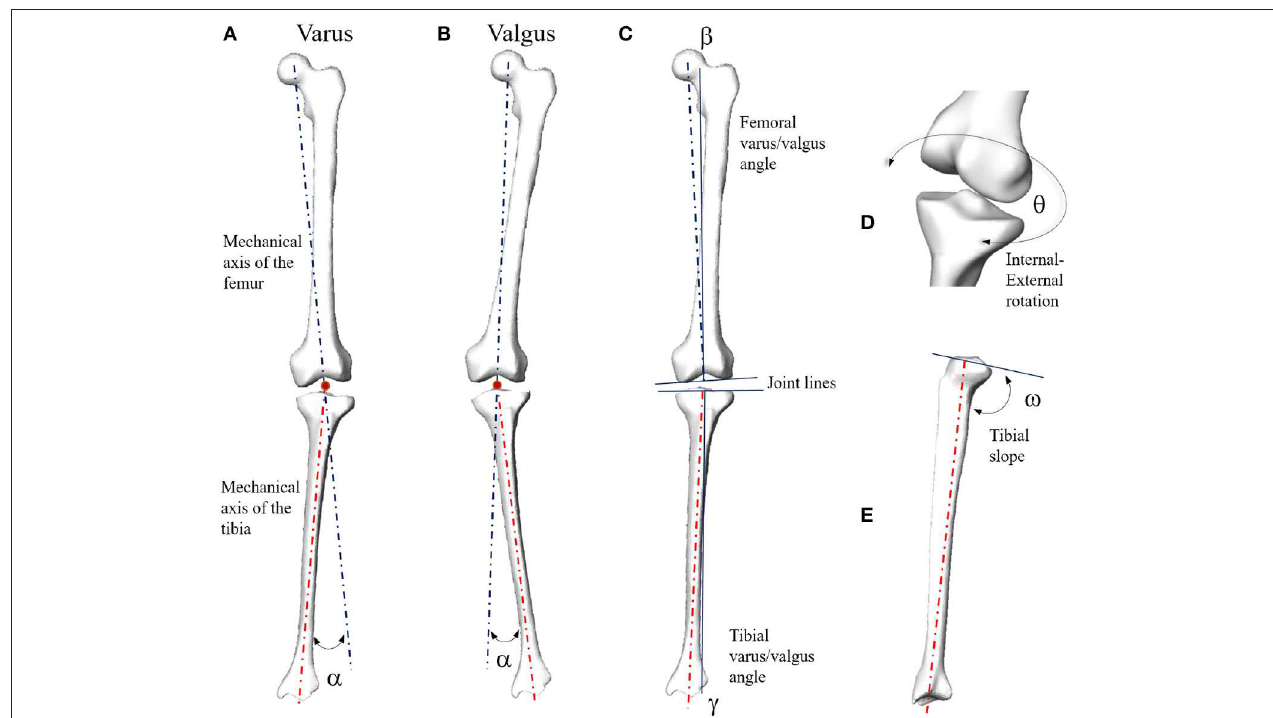
FIGURE 1 | Mechanical angular deformity ( α ) of the knee joint in the frontal plane ( A : varus; B : valgus). Femoral ( β ) and tibial ( γ ) varus/valgus angles computed with respect to the corresponding joint lines (C) . In case of parallel joint lines, β + γ = α . Internal-external rotation (D) and tibial slope (E)